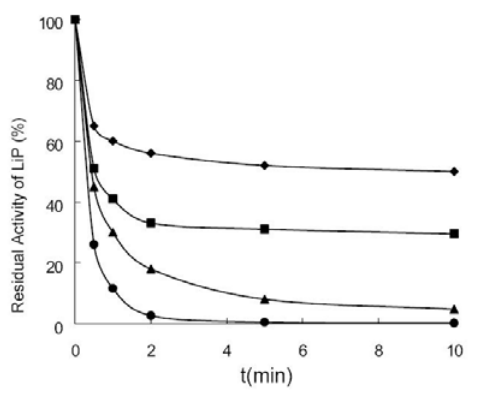
Fig. 5 Effects of VA and PR on the stability of LiP in the presence of H 2 O 2 . Conditions: LiP (1.0 μ M) was incubated with H 2 O 2 (120 μ M) in the mixed reversed micelles in the absence ( • ) or in the presence of either VA (40 μ M, ; 10 mM, ) or PR (40 μ M,